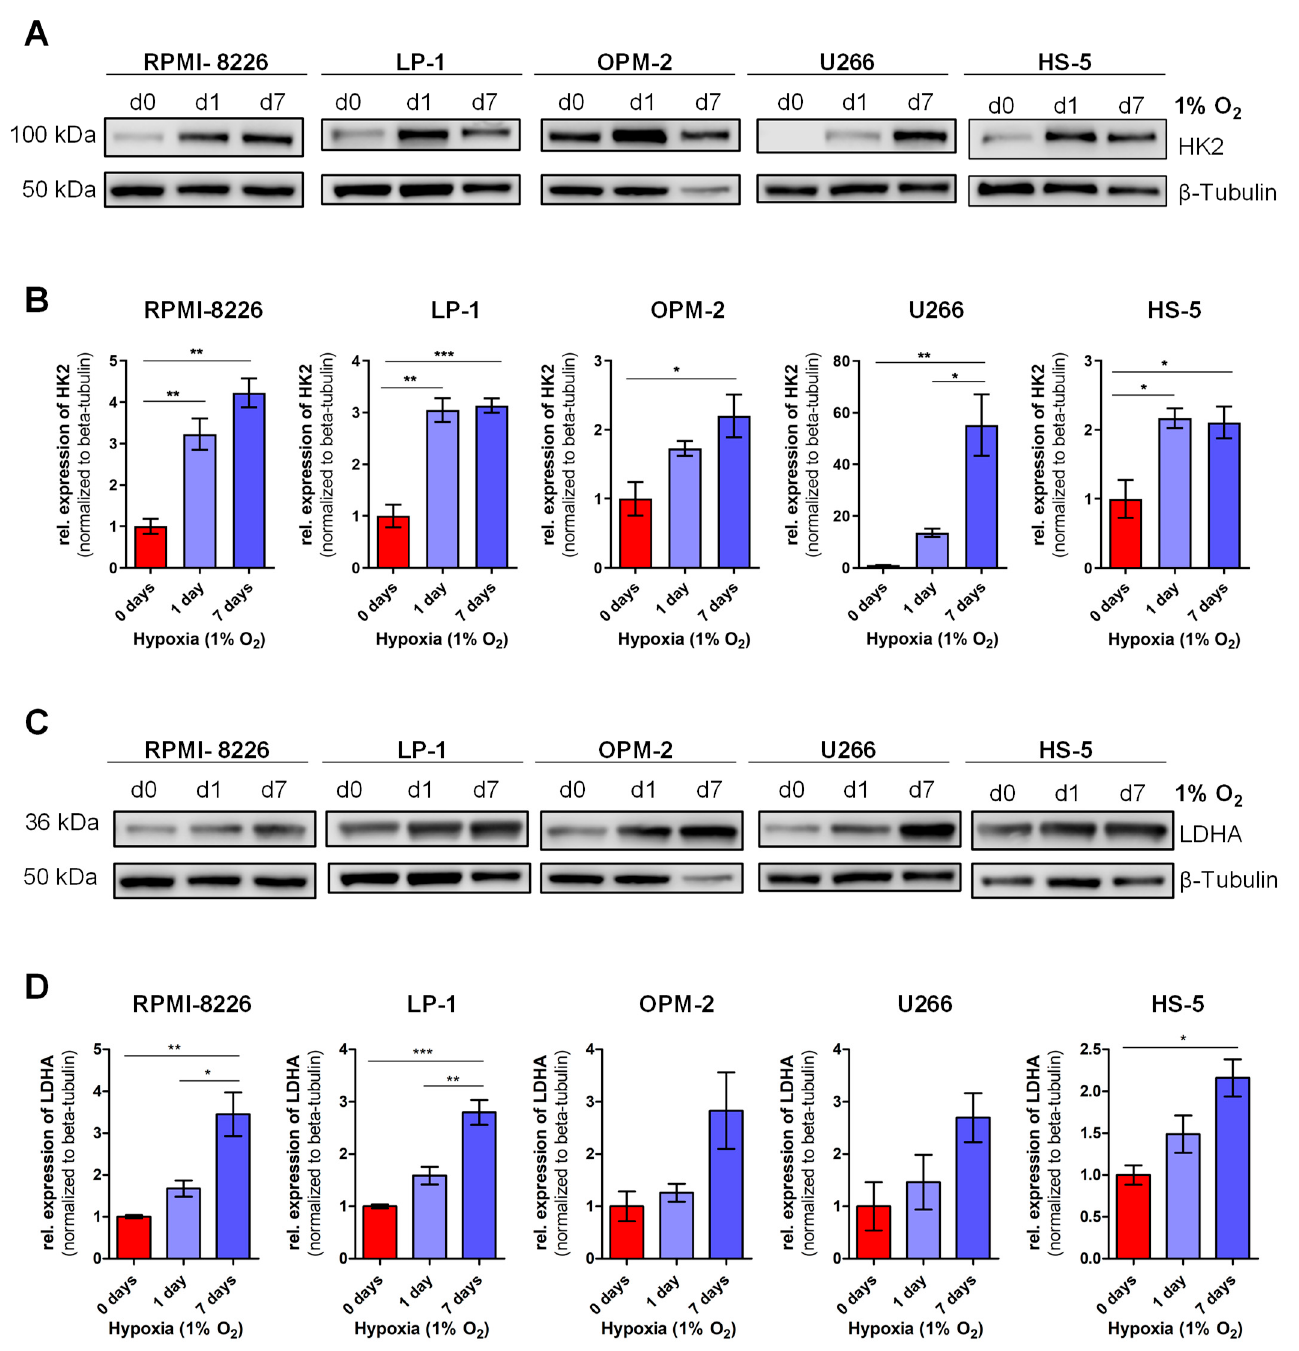
Figure 5. Hexokinase 2 and lactate dehydrogenase A protein expression in chronic hypoxia: Four MM cell lines and the bone marrow stromal cell line HS-5 were cultivated under hypoxic conditions and harvested at day 0, 1 and 7 for protein analysis. Representative Western blots for hexokinase 2 (HK2) ( A ) and lactate dehydrogenase A (LDHA) ( C ) are shown. Loading control: β -tubulin. Densitometric quantifications of protein expression are shown in ( B ) for HK2 and ( D ) for LDHA. Signals were normalized to β -tubulin expression. Bar graphs represent mean ± SEM of 3 independent experiments. One-way-ANOVA with Bonferroni’s post-hoc test. *, p < 0.05; **, p < 0.01; ***, p < 0.001. Abbreviations: d = day; rel. = relative; kDa = kilodalton; HK2 = hexokinase 2; LDHA = lactate dehydrogenase A.